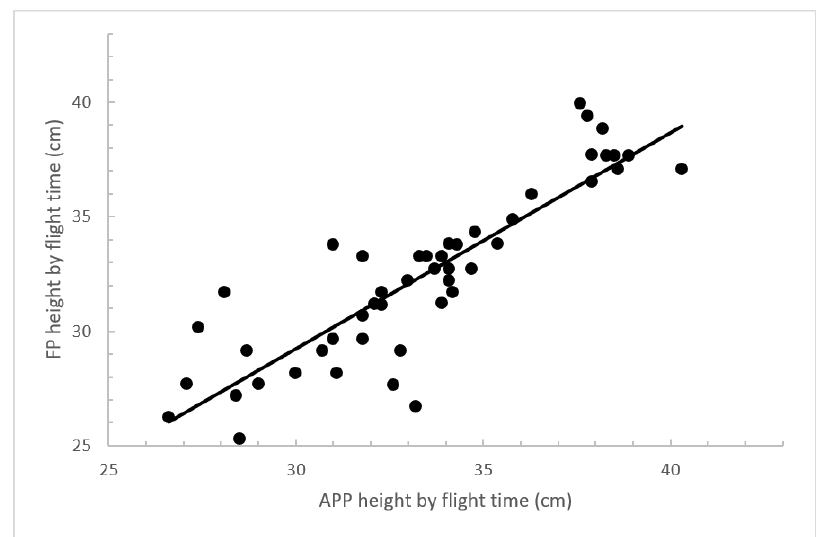
Figure 5. Pearson’s correlation between jump heights measured by the FP using flight time and the APP using flight time; FP, force platform; APP, My Jump App; graph made by the authors.